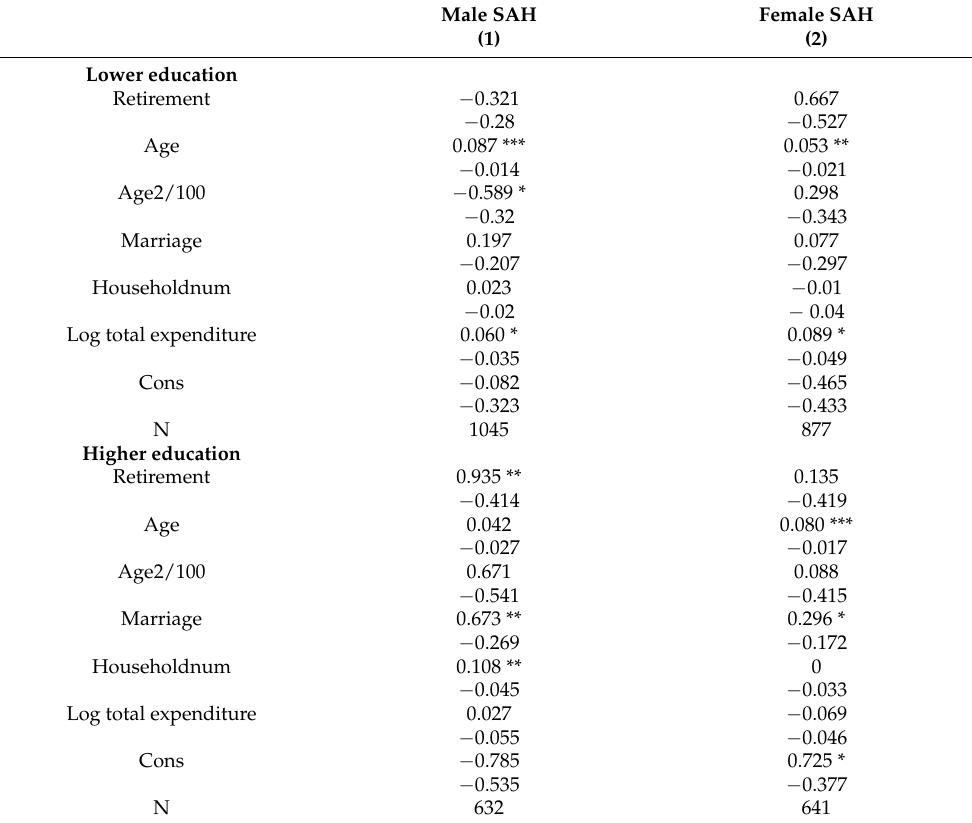
Table A5. Effect of retirement on SAH by education level.